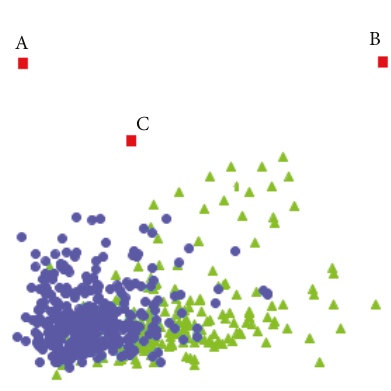
Figure 2: Example of objects A, B, and C being distance